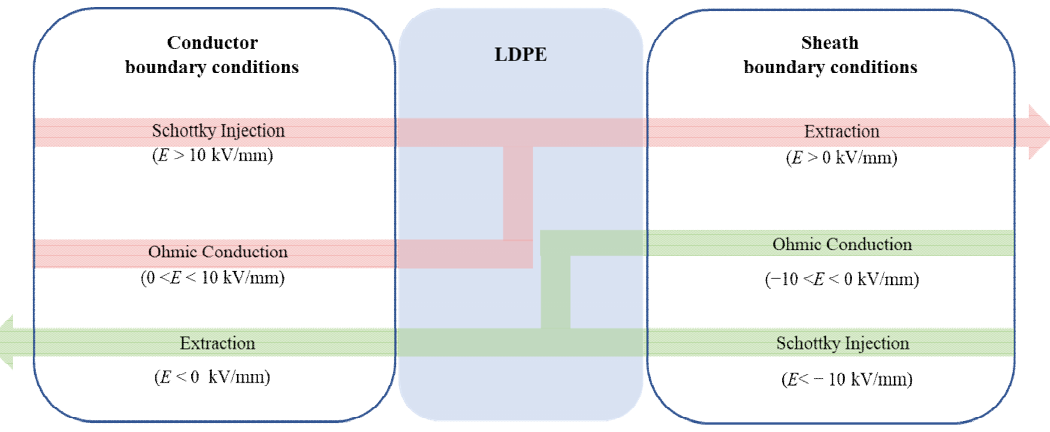
Figure 6. Modified boundary conditions considering both the direction and intensity of field. Red is direction of mobile holes at E > 0; green is direction of mobile holes at E < 0.